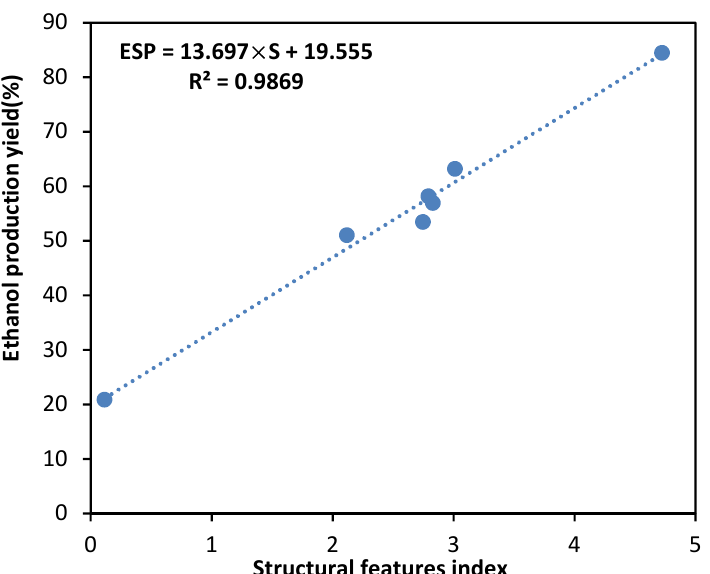
Figure 5. Linear relationship between ethanol production yield and structural features index of poplar wood.×